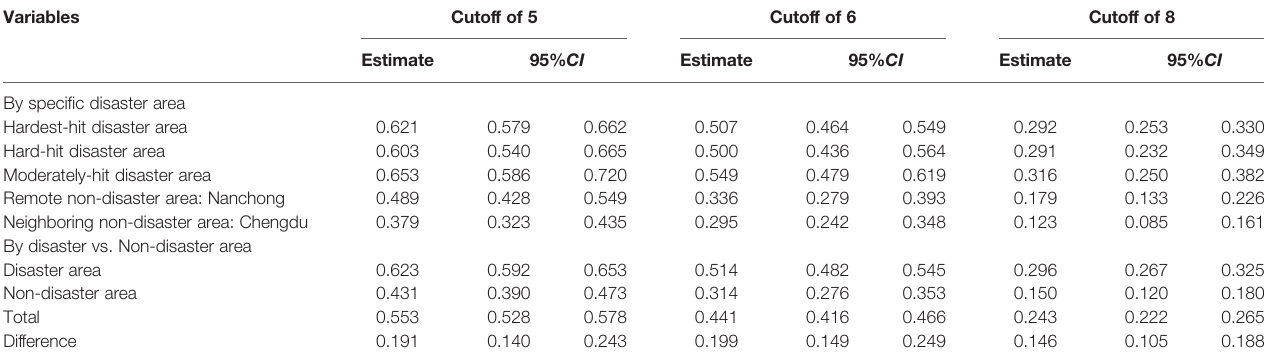
CI, con fi dence interval.